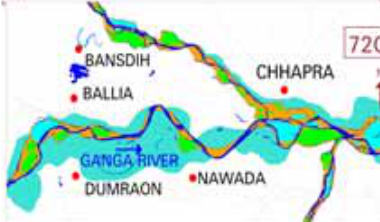
Fig 4 (c): Fluvial features as demarcated from 2000 post-